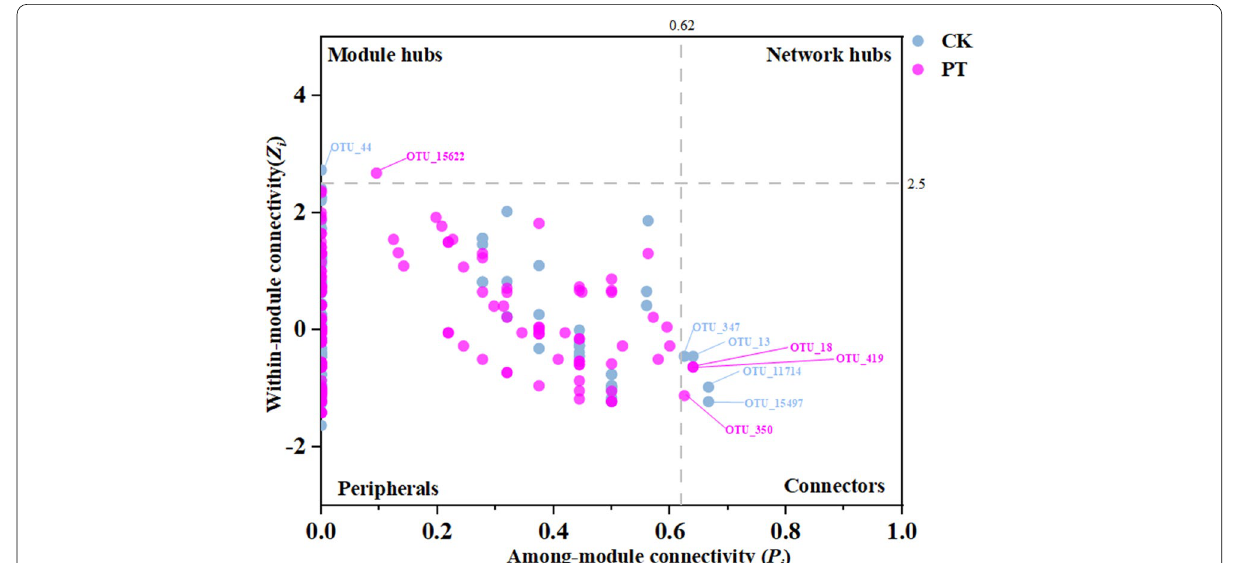
Fig. 8 The Zi-Pi plot exhibited the distribution of fungal OTUs based on their topological roles. The thresholds for Zi and Pi for classifying OTUs are 2.5 and 0.62,